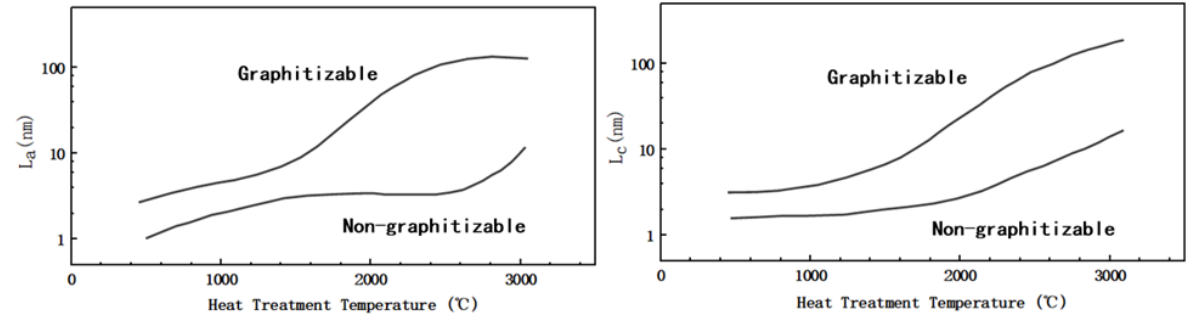
Figure 4. Schematic diagram of L a and L c of soft and HC changing with treatment temperature (modified by reference [59]).